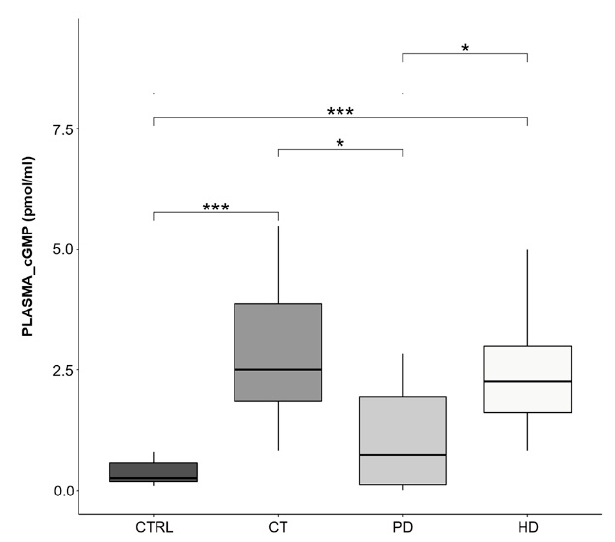
Figure 5. Plasma cGMP levels. Box plots represent plasma cGMP levels in the four study groups (CTRL, CT, PD, HD; N = 10 for each group). cGMP concentration was evaluated through ELISA and expressed as picomoles/milliliters (pmol/mL). Horizontal black lines indicate the medians, boxes the interquartile range (IQR) and the bottom and top whiskers represent the minimum and maximum values. (* p < 0.05; *** p < 0.001).